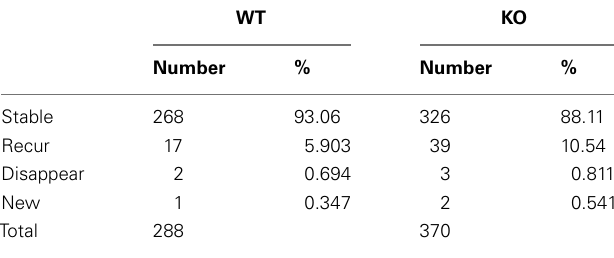
Table 1 | Number of